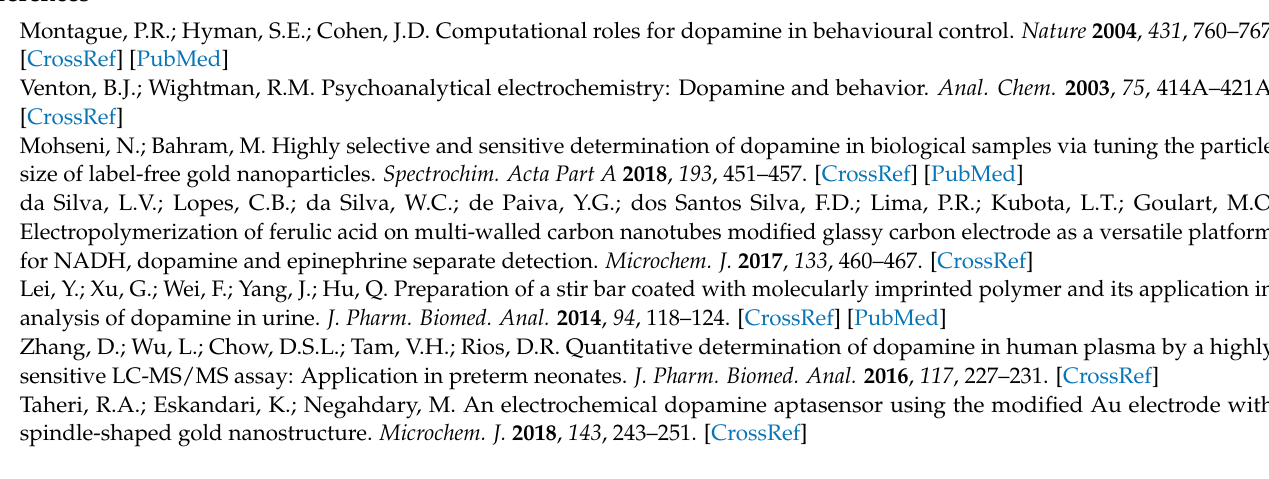
Figure S3: Fluorescence spectrum (A) and fluorescence intensity (B) of C-dots under various reaction time when the amount of water remains unchanged at a temperature of 180 ◦ C ( λ em = 345 nm), Figure S4: The quenching fluorescence spectra of the system by DA; Inset: the calibration graph of the corrceted fluorescence quenching and different concentrations of DA, Figure S5: The UV-vis absorption spectrum of C-dots and DA at different